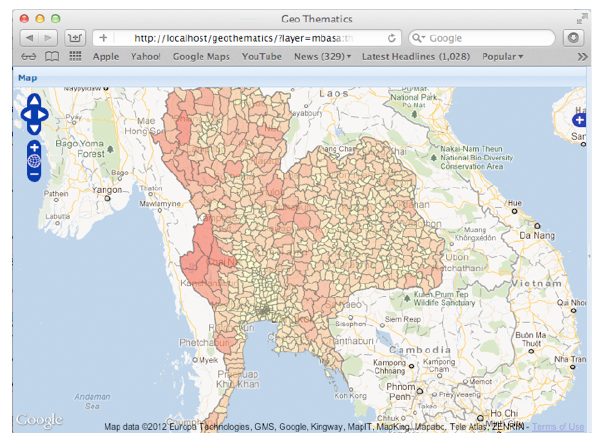
Figure 2. An output choropleth map produced from